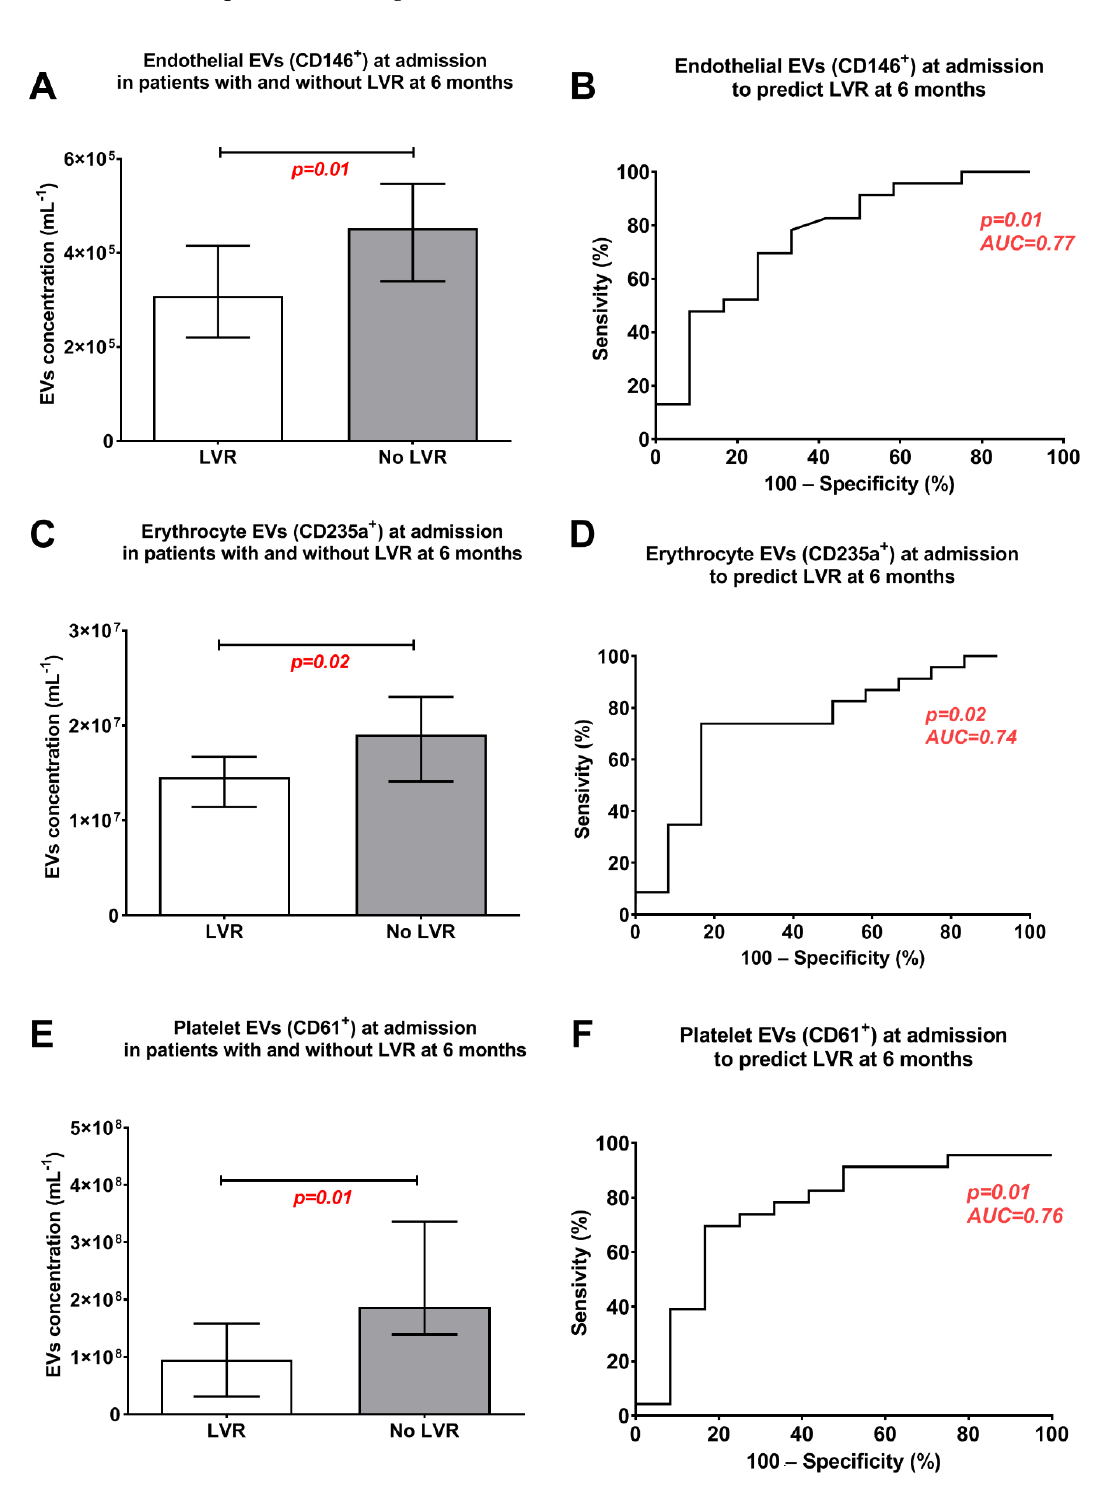
Figure 2. Concentrations of extracellular vesicles (EVs) measured with flow cytometry in platelet-depleted plasma prepared from patients with and without left ventricle remodelling (LVR) 6 months after AMI. ( A , B ): EVs from endothelial cells. ( C , D ): EVs from erythrocytes. ( E , F ): EVs from platelets.